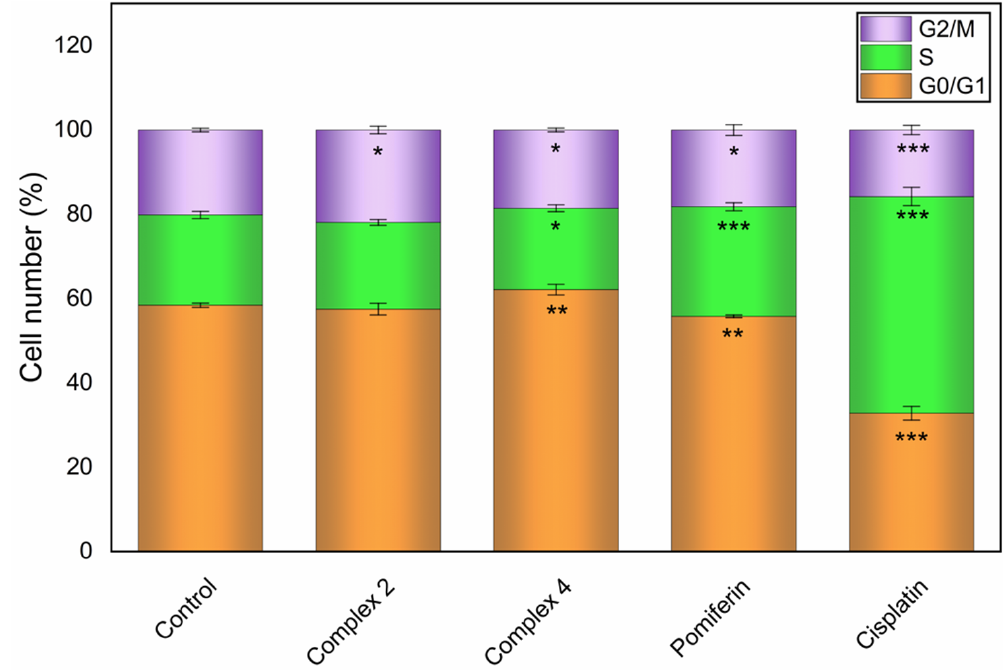
Figure 2. Cell cycle modifications of the A2780 cells induced by complexes 2 and 4 , pomiferin and cisplatin applied at 15 µ M after 24 h of incubation. The significant change in the number of cells in a specific phase of the cell cycle caused by the respective complex as compared to the untreated control is symbolized by * at p ≤ 0.05 level, ** at p ≤ 0.001 level and *** at p ≤ 0.0001